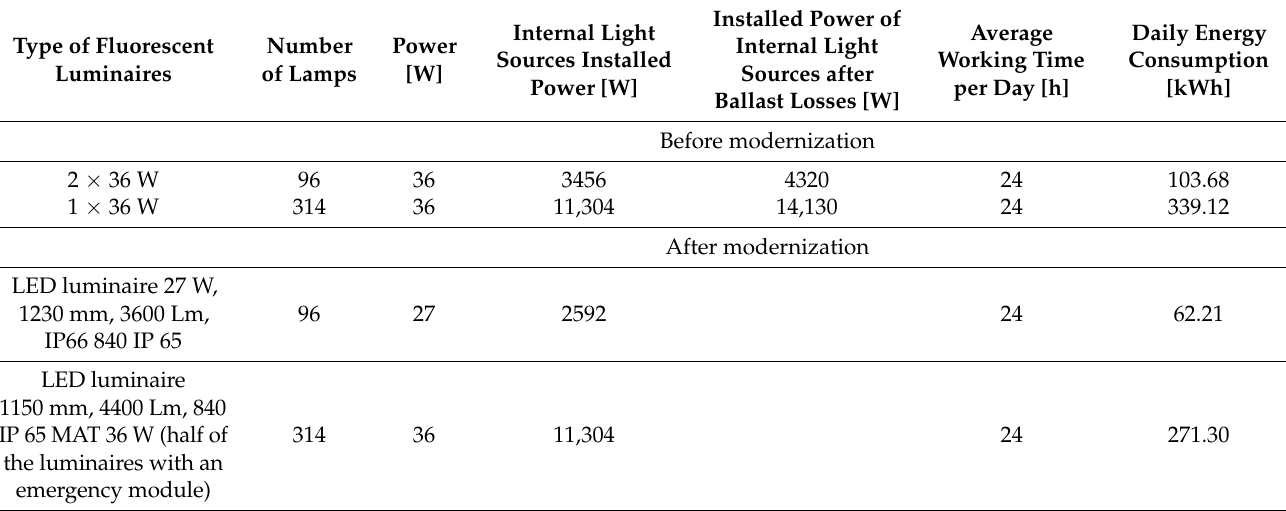
Table 2. The lighting of underground garages before and after